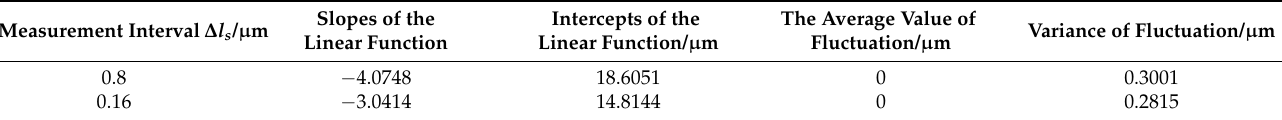
Table 1. Detailed parameters under the two